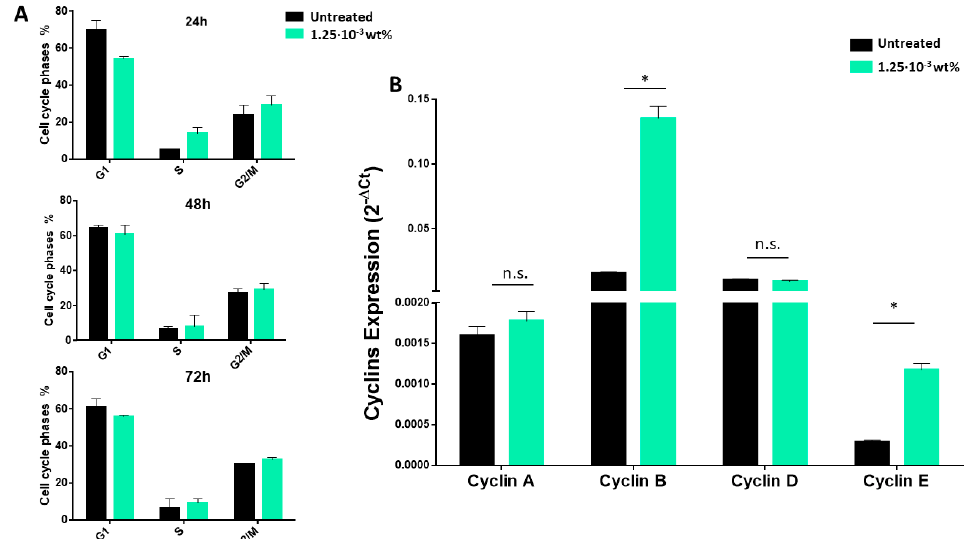
Figure 4. Fmoc-FF nanogels cause cell cycle arrest in MDA-MB-231 cells. ( A ) Percentage of MDA- MB-231 cells present in G0-G1, S, and G2-M phases upon treatment with Fmoc-FF nanogels at 1.25 × 10 − 3 wt% for 24 h (top panel), 48 h (middle panel), and 72 h (lower panel). The percentages are reported as the mean of three independent experiments +/ − SD. ( B ). mRNA levels of the indicated cyclins in untreated (black bars) MDA-MB-231 cells and upon 24 h of treatment with 1.25·10 − 3 wt% Fmoc-FF nanogels (red bar). The relative expression was determined using the 2 − Δ Ct method. Cyclins relative expression is shown as the mean +/ − SD of three technical independent experiments. * = p -value < 0.05, Mann Whitney t -test; n.s. = not signi fi cant.